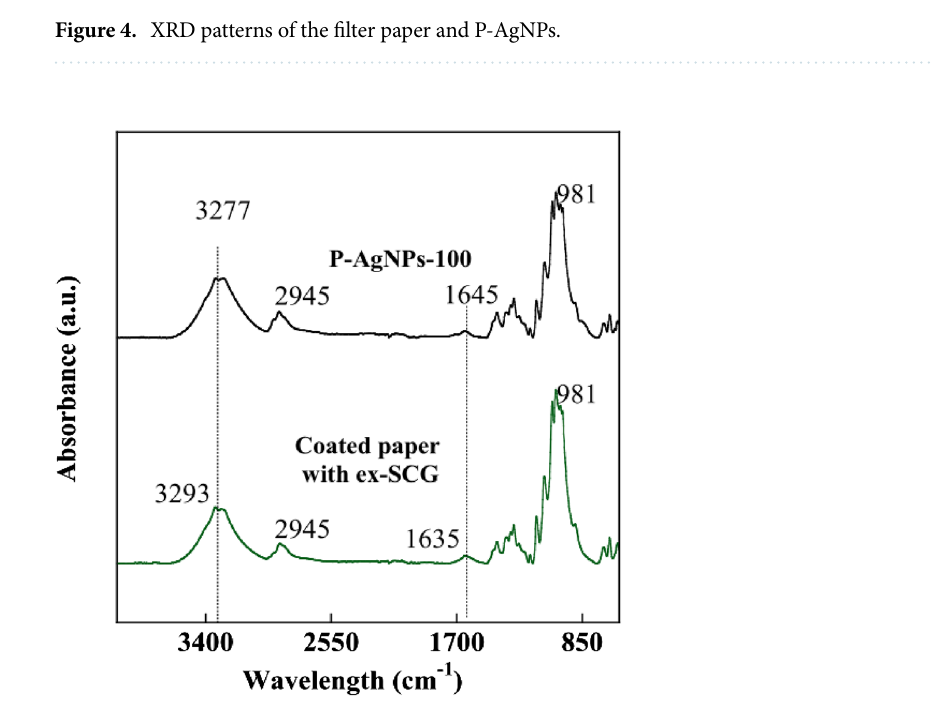
Figure 5. ATR-FTIR spectra of the paper coated with ex-SCG and